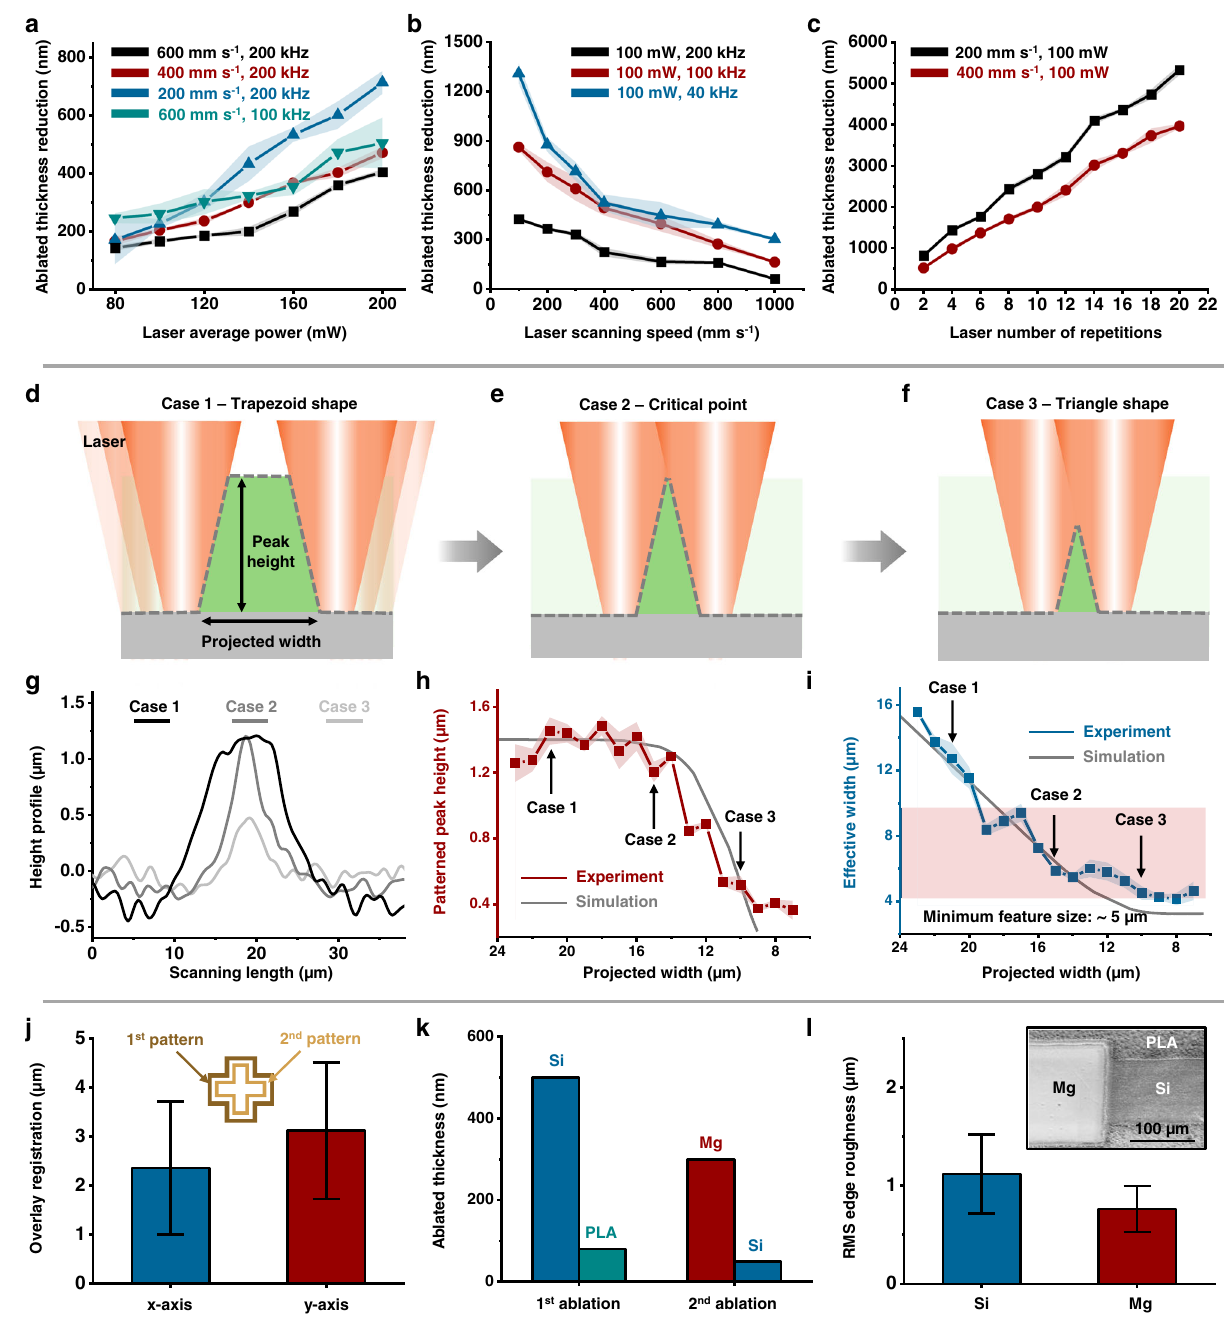
Fig. 2 | Key characteristics of the ablation process. Controlled reductions in thicknessesofmonocrystallineSiMMsachievedbyablation,andtheirdependence on ablation parameters, including average power ( a ), scanning speed ( b ), fre- quency( b ),andthe numberofrepetitions( c )at fi xedgrid distance(7 µ m)and grid mode (XY-parallel). The shaded areas denote the standard deviation. Schematic illustration of cross-sectional pro fi les of ribbon-shaped structures of mono- crystalline Si MM formed by ablation; a trapezoid shape with a titled edge (pro- jected widthlargerthanthe laserspotdiameter D laser ;case1; d ), atriangle shape at the critical point (projected width similar to D laser ; case 2; e ), and a proportionally reduced triangle shape (projected width smaller than D laser ; case 3; f ). g Experimentally measured pro fi les for these three cases. Peak height ( h ) and effectivewidth( i )asfunctionsofprojectedwidth.Theeffectivewidthcorresponds to the integrated cross-sectional area divided by the peak height. The minimum